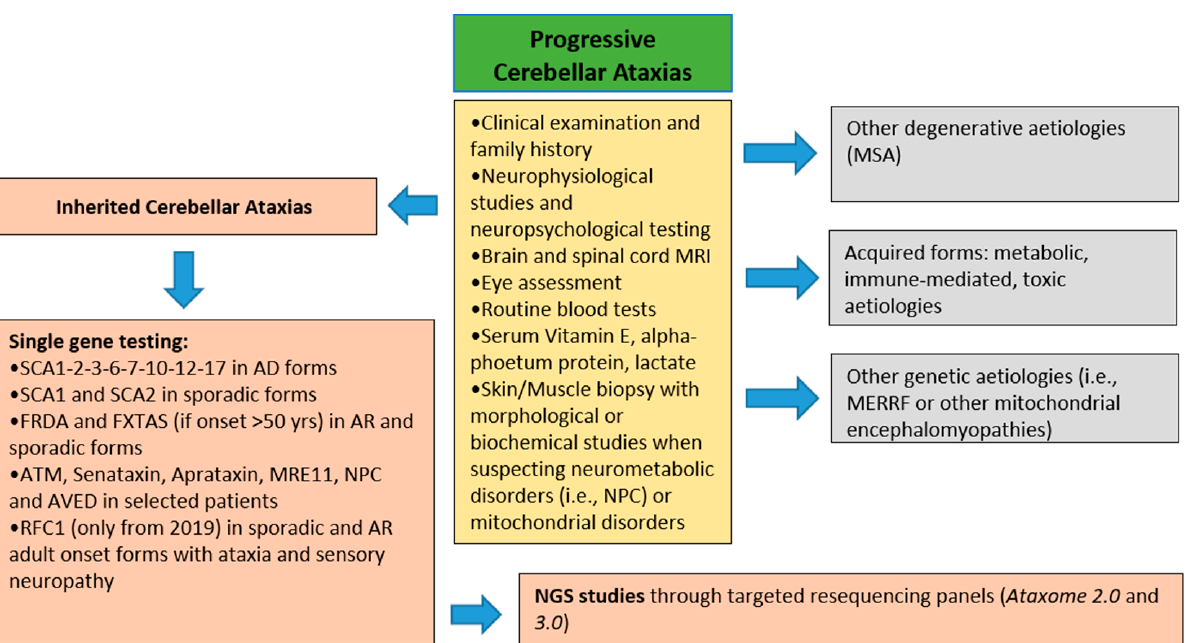
Figure 2. Diagnostic flowchart applied at the suspected degenerative cerebellar ataxia patients. Abbreviations: SCA, SpinoCerebellar Ataxia; FRDA, Friedreich’s Ataxia; FXTAS, Fragile X-associated tremor/ataxia syndrome; AD, autosomal dominant; AR, autosomal recessive; ATM, ataxia-telangiectasia mutated; NPC, Niemann-Pick disease type C; AVED, Ataxia with vitamin E deficiency; RFC1, replication factor complex 1; NGS, Next-Generation Sequencing. Table 1. Genetic diagnosis reached at the first-tier screening. Abbreviations: HSP, Hereditary Spastic Paraplegia; CA, Cerebellar Ataxia; AD, autosomal dominant; AR, autosomal recessive; SGT, single gene testing.